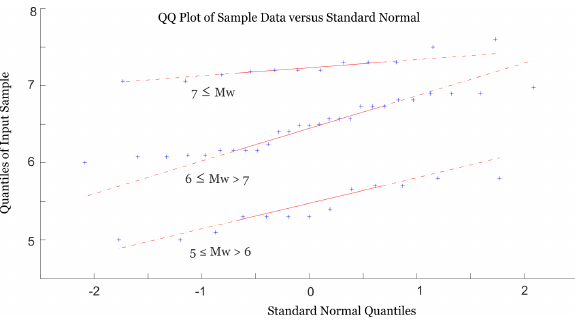
Figure 7: The quantile-quantile (QQ) plot of magnitude of earth- quake (M w )